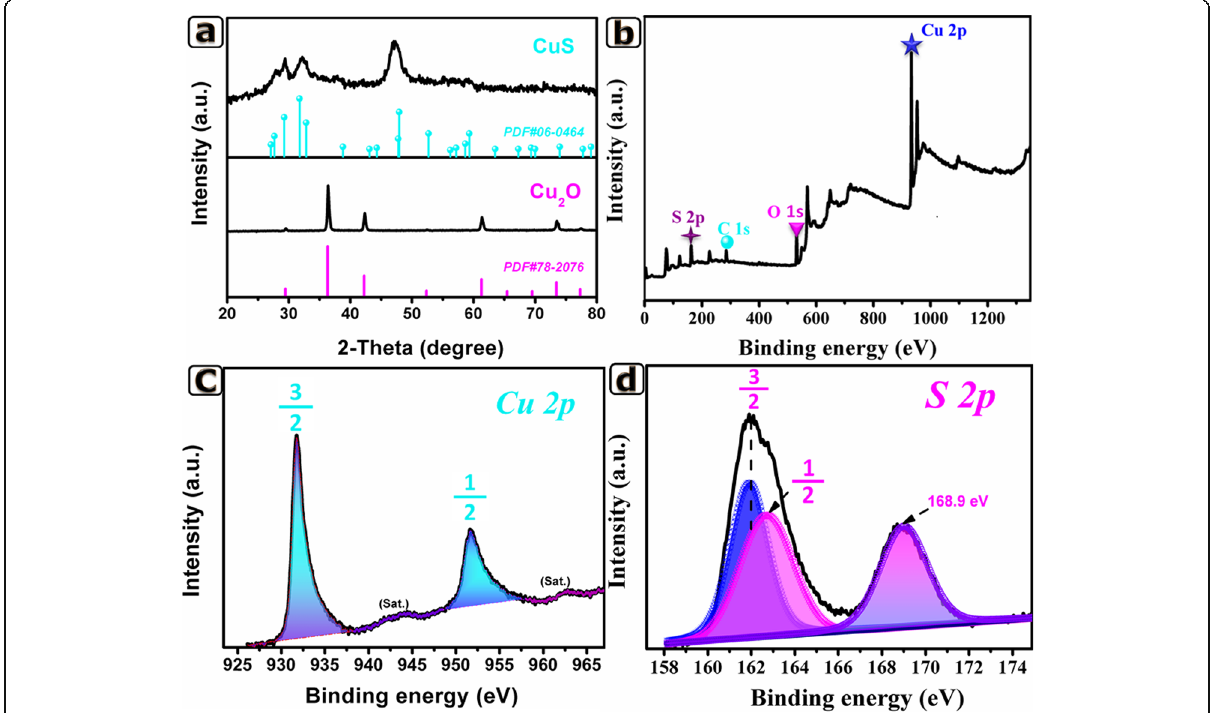
Fig. 2 a XRD pattern of 2-CuS NCs and Cu 2 O. b XPS survey spectrum for the product. c Cu 2p. d S